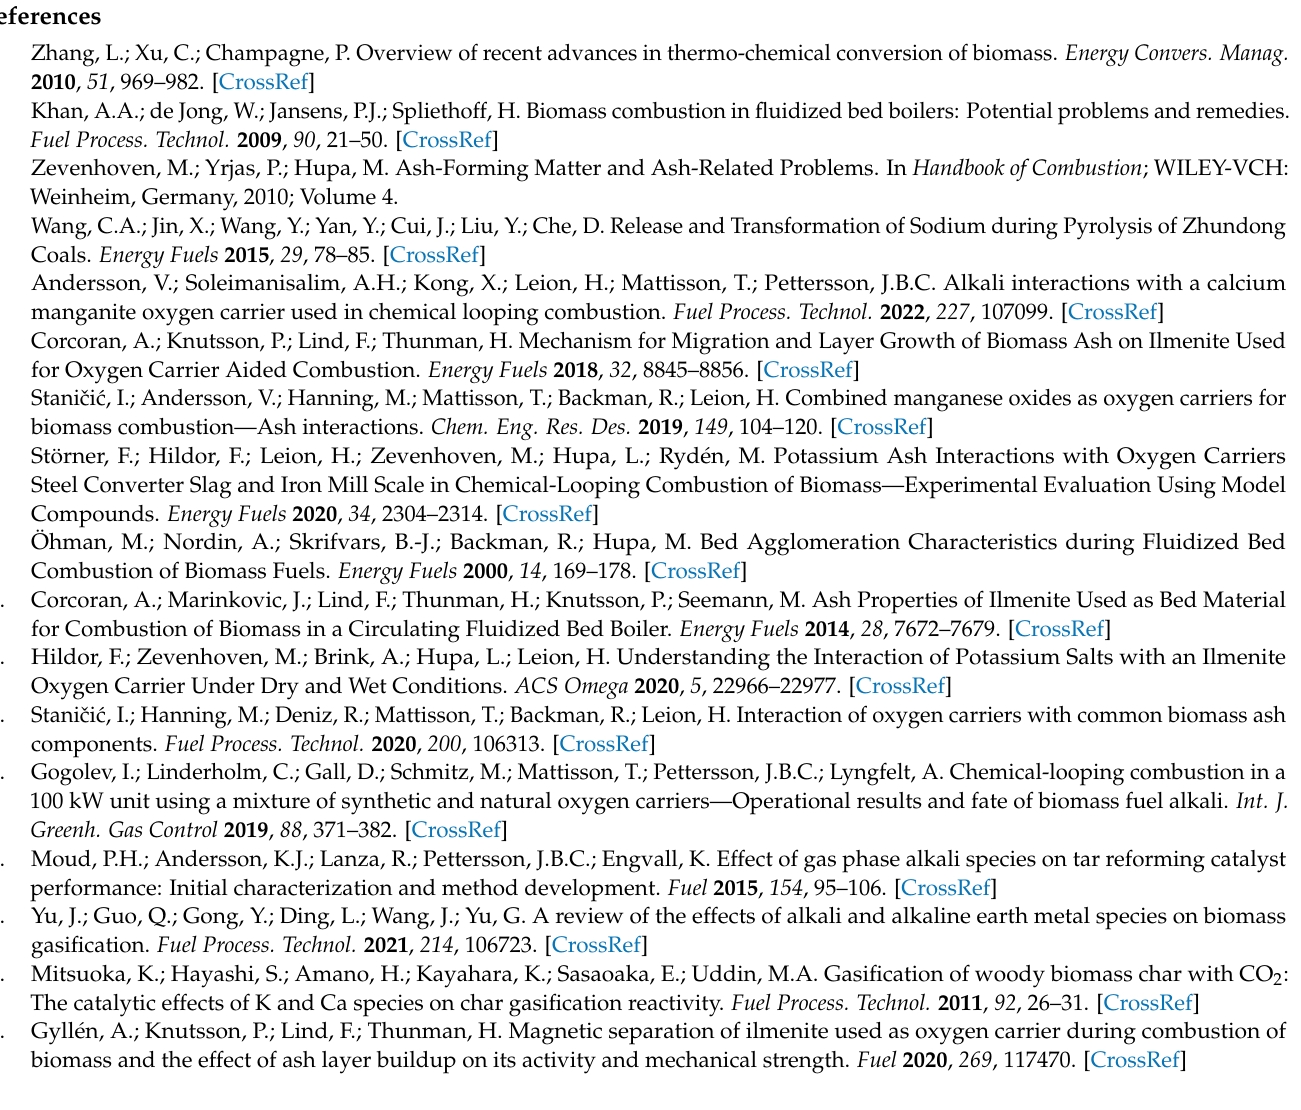
Figure S2: Resulting gas velocity as vectors from CFD simulations of the TGA when operated at a constant temperature of 1000 ◦ C in air. The 11 mm wide sample holder can be used as a reference for